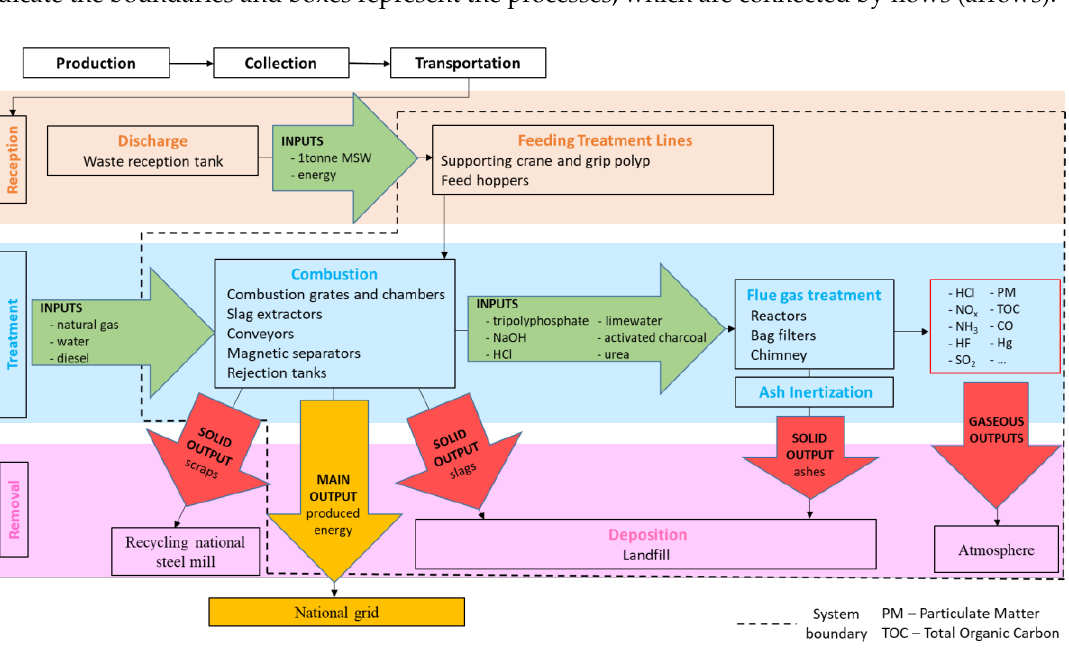
Figure 3. Flowchart of the present LCA study, with defined boundary, inputs and outputs.